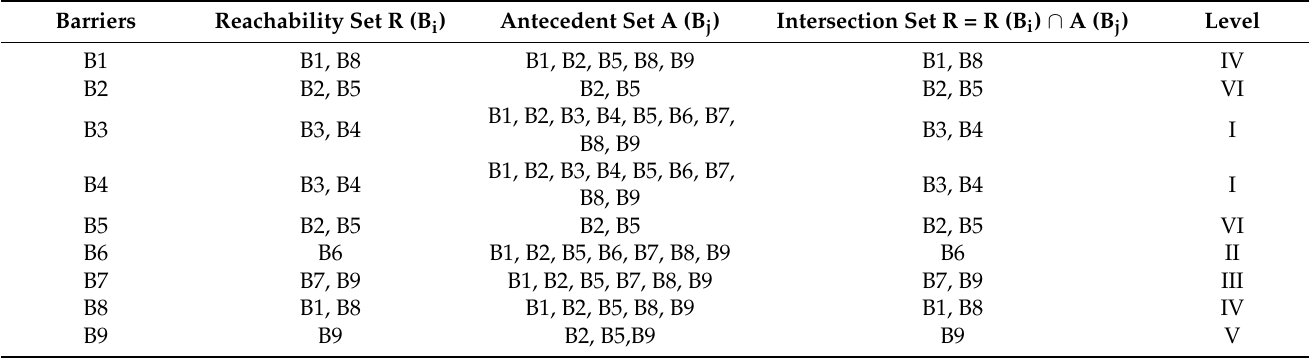
Table 8. Result of level partition iteration.